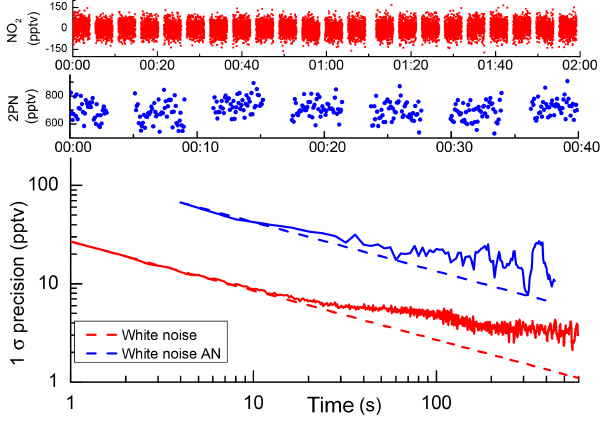
Figure 15. The upper panel (red data points) displays a time series of raw NO 2 data (5s intervals) when sampling zero air. The mid- dle panel (blue data points) shows a series of measurements when sampling a constant flow of 2-propyl nitrate ( ∼ 700pptv) from the 723K inlet. The lower panel is an Allan deviation plot showing the dependence of the measurement precision (1 σ) on the signal inte- gration time in the reference cavity (red curve) and TD cavity (blue curve). The dashed lines represent precision expected for random